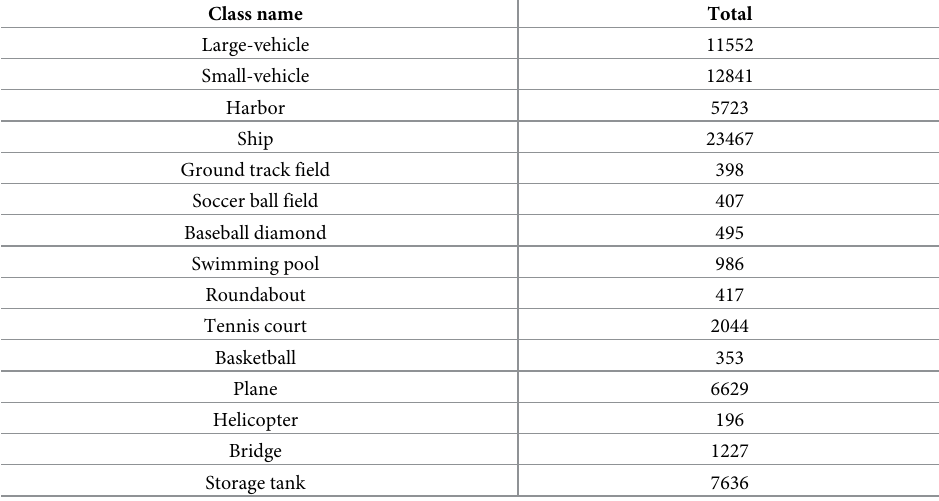
Table 6. DOTA dataset categories